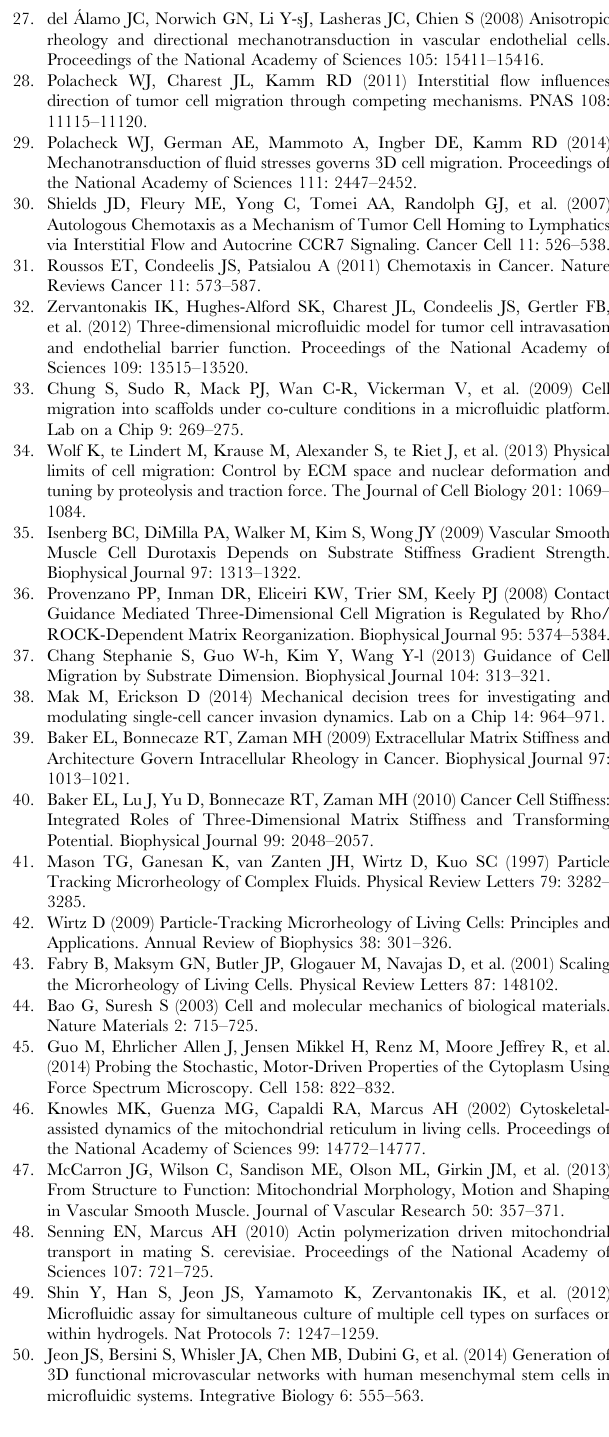
Brownian dynamics